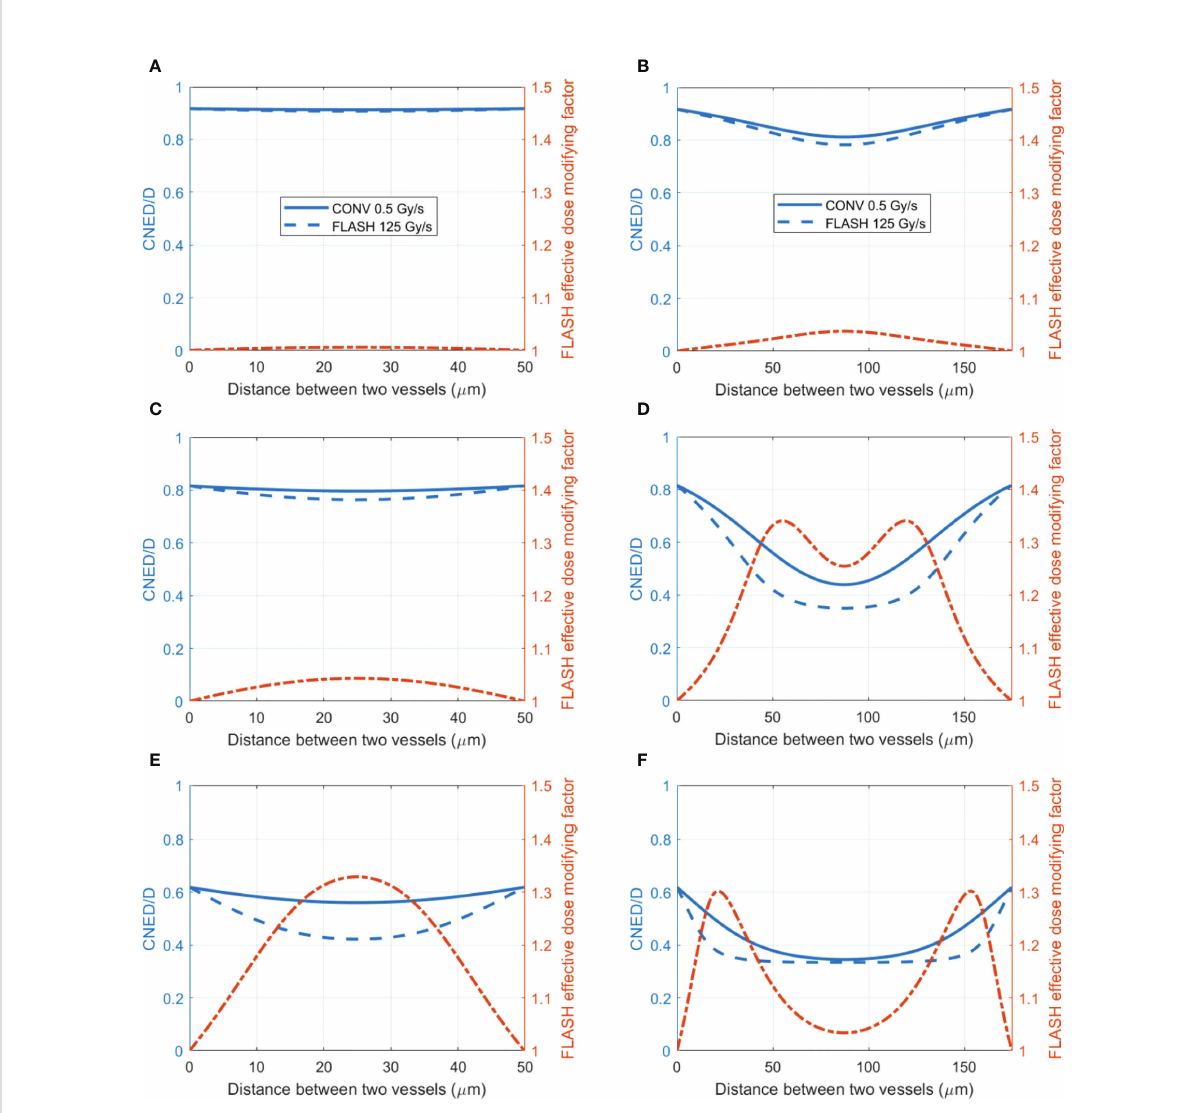
FIGURE 5 The ratio of CNED to delivered dose D and FLASH effective-dose-modifying factor for different vasculature intraspacings and oxygen BCs. (Left axis) The ratio of the CNED to the delivered 15 Gy dose under conventional 0.5 Gy/s (solid blue) and UHDR 125 Gy/s (dashed blue) dose rates; (right axis) the FLASH effective-dose-modifying factor derived from the CNEDs under the two dose rates. Two different vasculature spacings [ (A, C, E) 50 m m; (B, D, F) 175 m m] with high 50.4 (A, B) , medium 18.9 (C, D) , and low 5.4 m M (E, F) BCs are